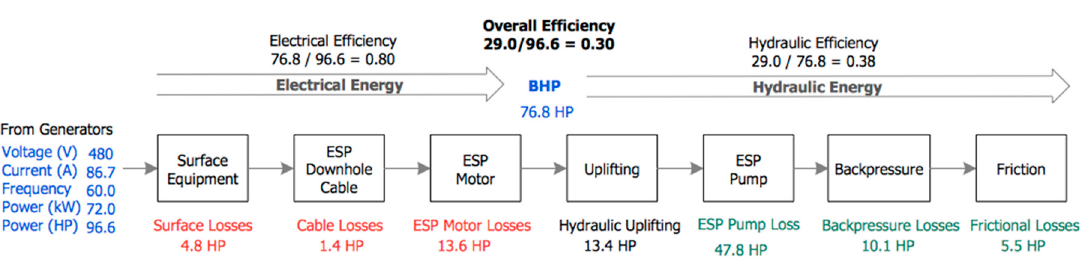
Figure 8. Energy balance for ESP-06.